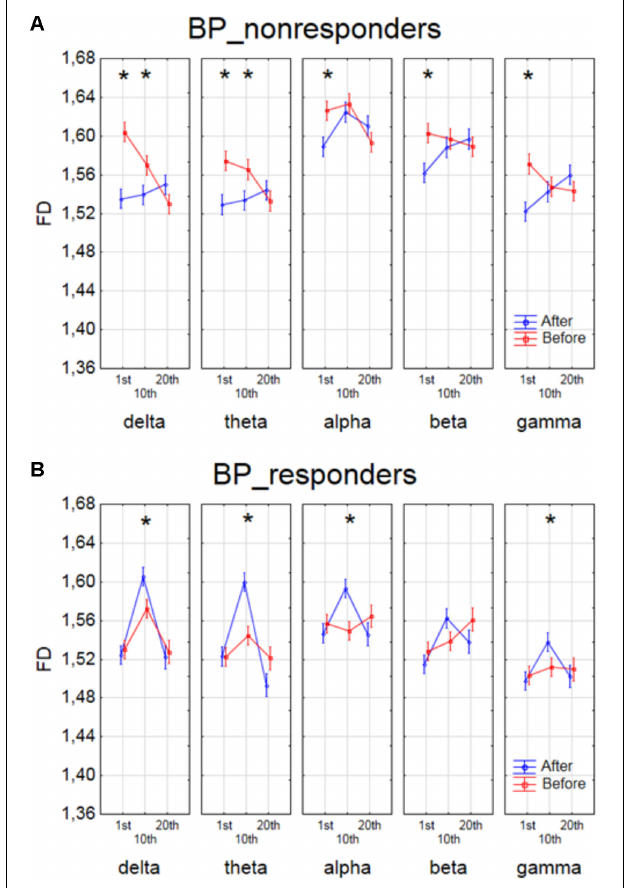
FIGURE 4 | Higuchi fractal dimension for BP_non-responders group (A) and for BP_responders group (B) for each band separately, showing changes in FD values before and after 1st, 10th and 20th session. The interaction between factors CONDITION, BAND and SESSION (separately for every group of BP patients). Significant differences between conditions for the individual sessions and bands, evaluated by post hoc Tukey HSD test, were marked with asterisks.